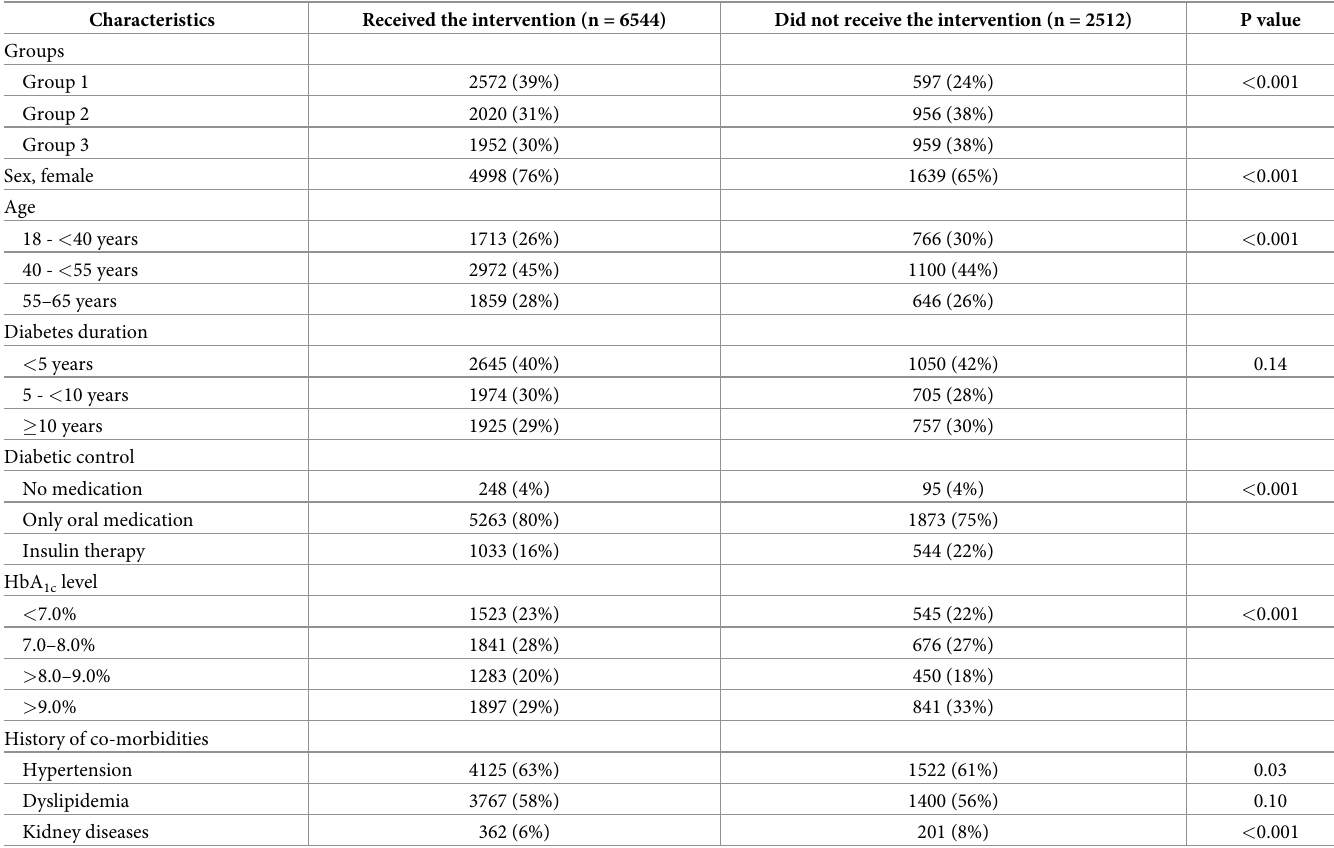
Table 2. Characteristics of participants who received a behavioural support group session for melioidosis prevention.